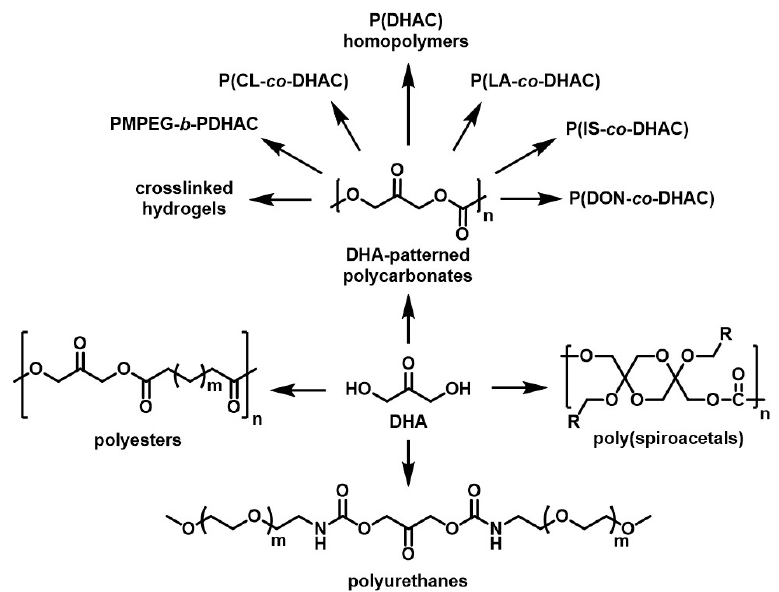
Figure 16. Scheme of the various DHA-based polymers reported so far.